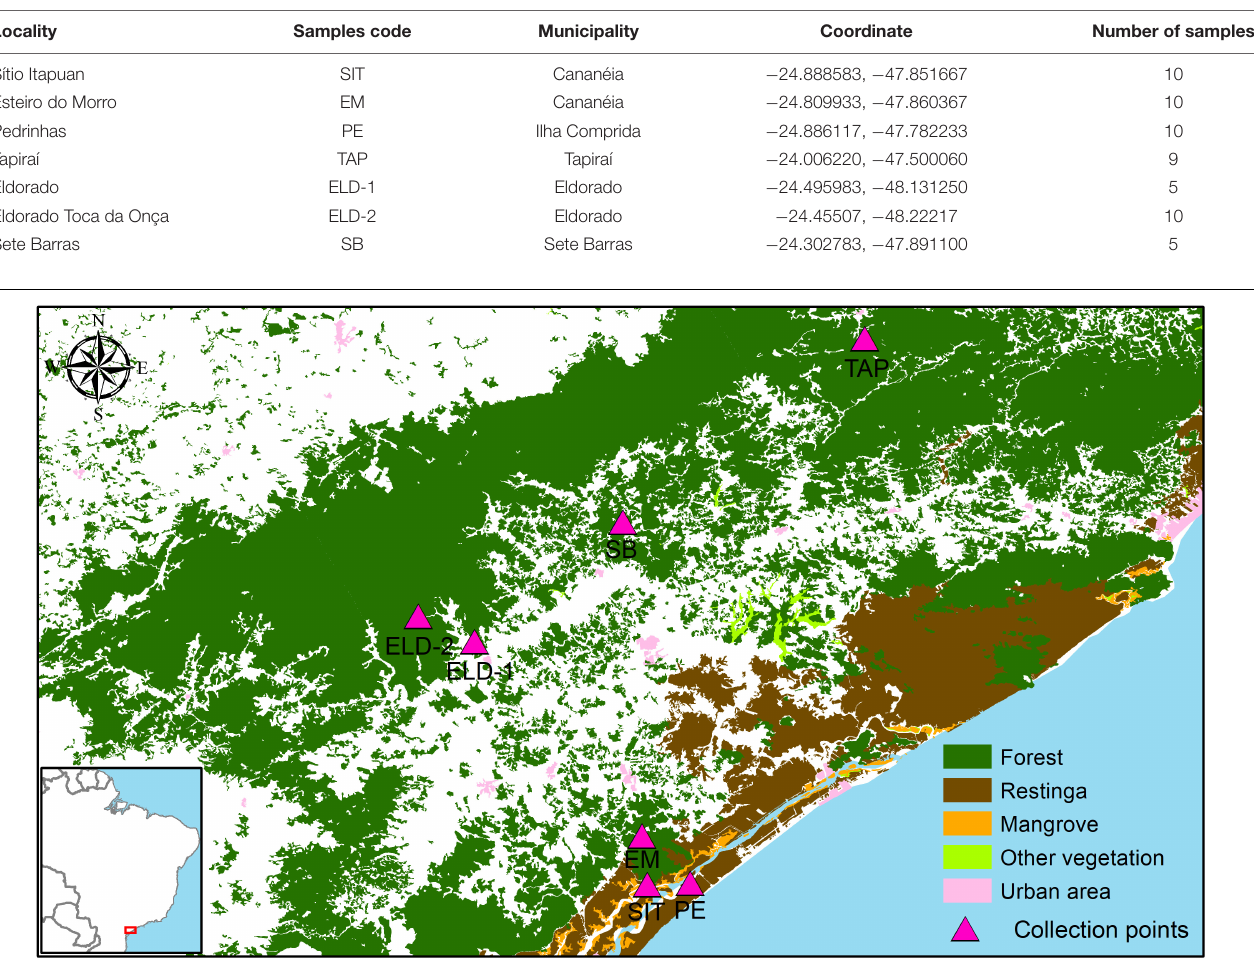
FIGURE 1 | Study region: Ribeira Valley, Southeastern São Paulo State, Brazil. Field collection points were utilized for sampling from mosquito fauna in remnants of the Brazilian Atlantic rainforest conserved in the study region. Source: SOS Mata